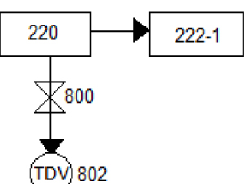
Fig. 5. RELAP5-3D nodalization diagram of the break.